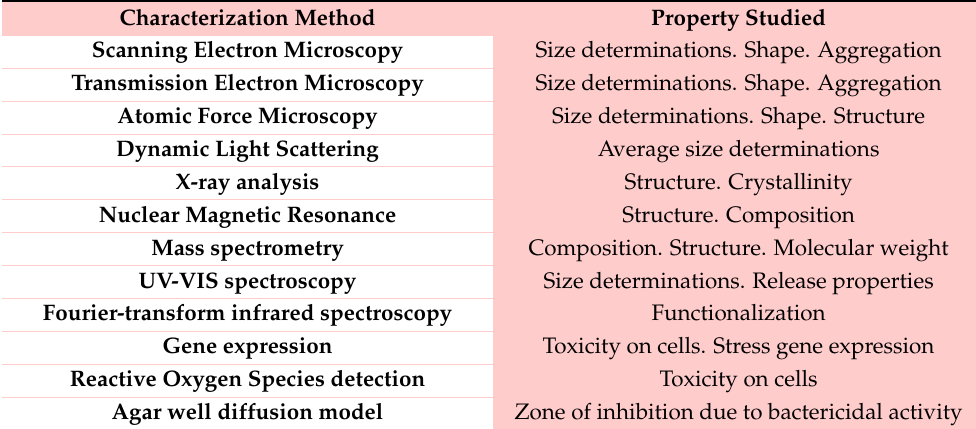
Table 4. Advanced characterization techniques for Ag-NPs